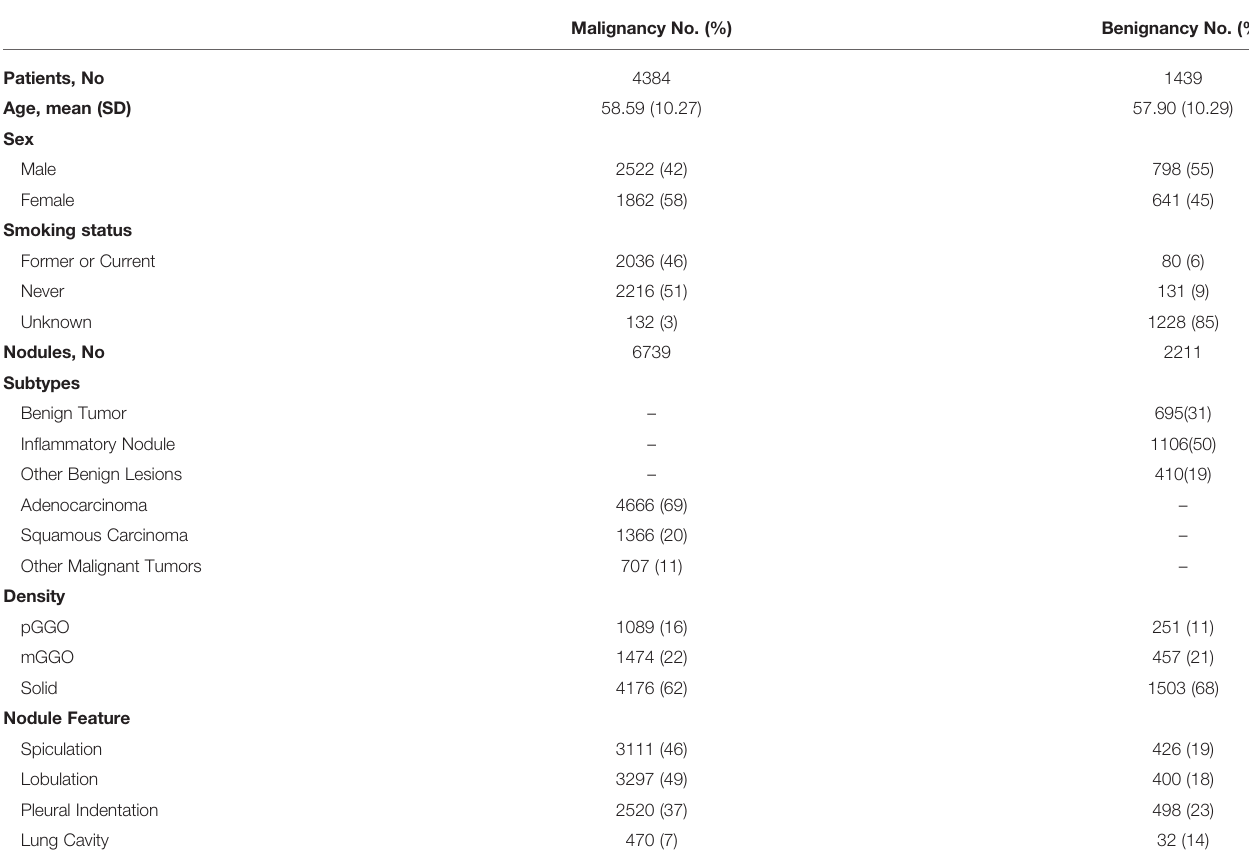
TABLE 1 | Characteristics of included patients and nodules